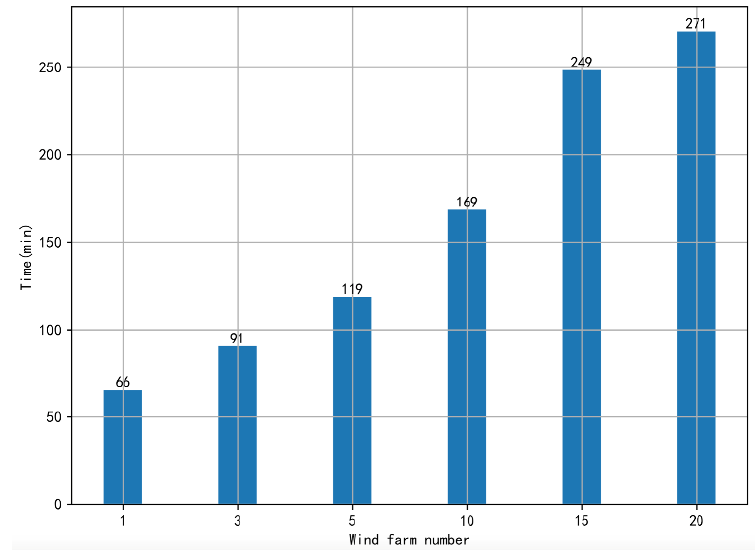
ff erent wind farm